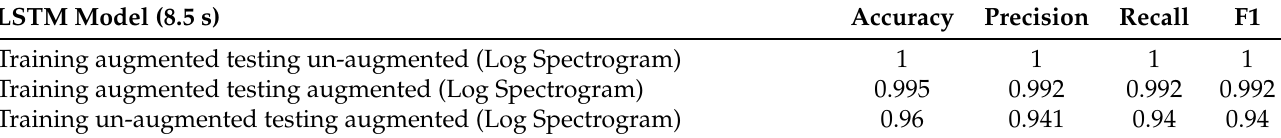
Table 15. Results of LSTM model with log Spectrogram.